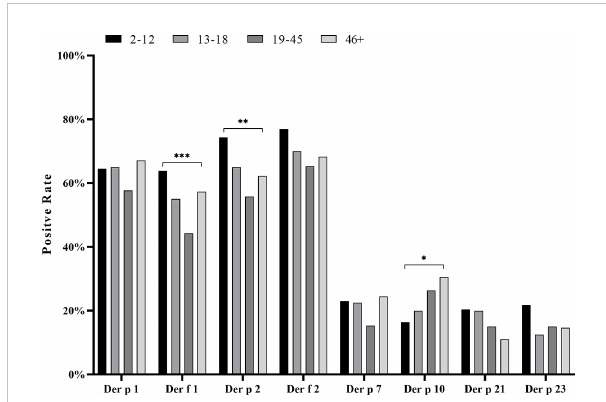
FIGURE 5 Positive rate of house dust mite component sIgE within four different age groups. Compared by chi-square test, the positive rate of each whole age group was analyzed. * p < 0.05; ** p < 0.01; *** p < 0.001.